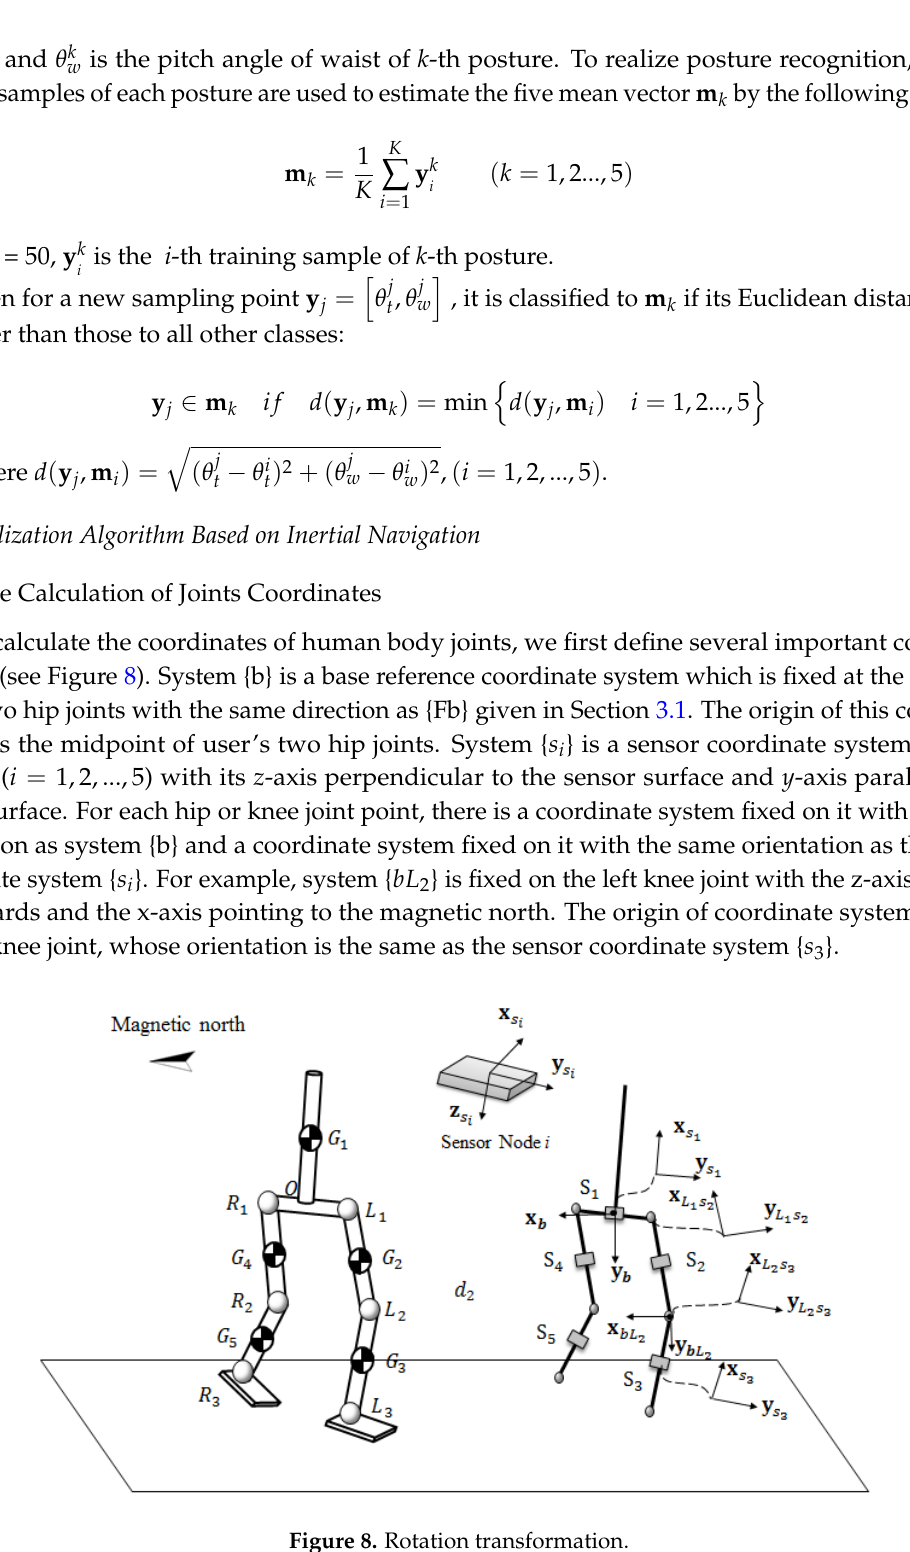
Figure 8. Rotation